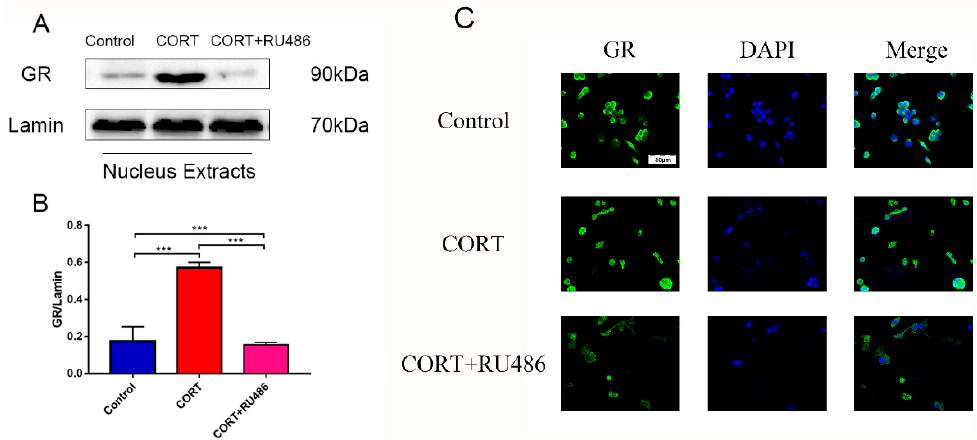
Figure 4. The relevant expression of nuclear proteins in HT22 cell nuclear lysates after cortisol (CORT) treatment for 3 h with or without RU486 as assessed by western blotting and relative density analyses. ( A ) The glucocorticoid receptor (GR) and lamin expressions in each group. Expression levels were quantitated by measuring band intensities using Image Lab software. The graphs indicate densitometric analyses using the expression ratios of ( B ) GR / lamin. The results are expressed as the mean ± SD (n = 3) in each independent experiment analyzed by one-way analysis of variance. *** p < 0.001. The GR localization was detected by immunofluorescence staining with or without 400 µ M CORT treatment for 3 h with or without RU486 treatment.